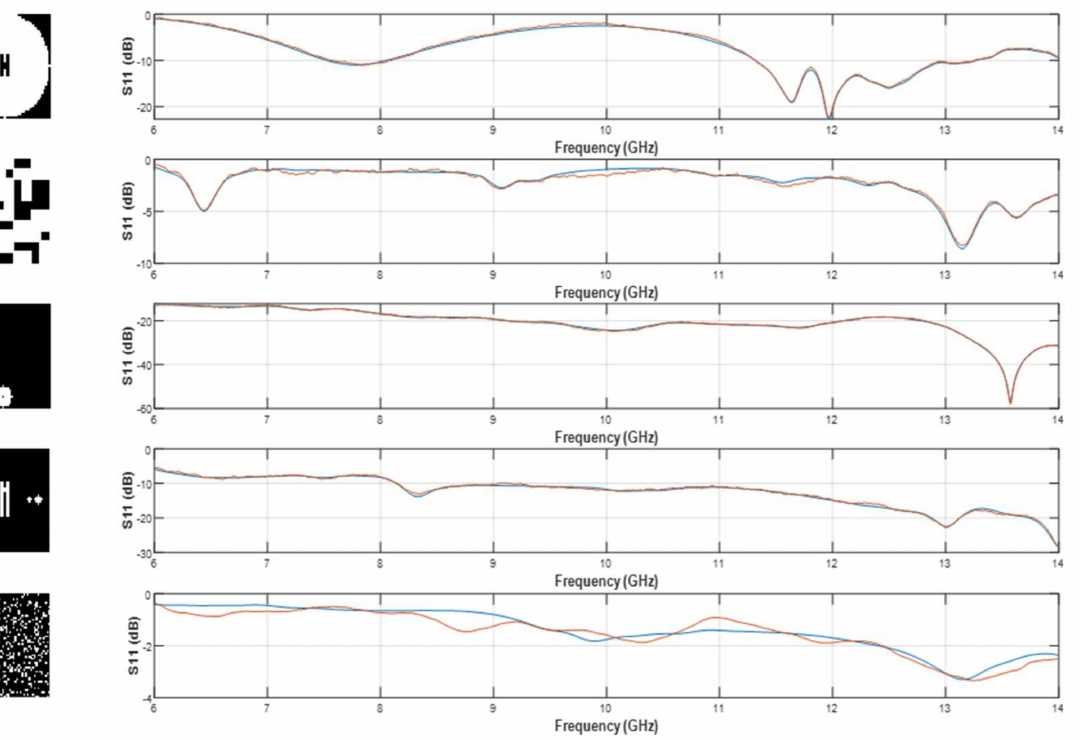
Figure 5. Five random examples of Model-2. The orange line represents Model-2’s result, and the blue line represents the simulation